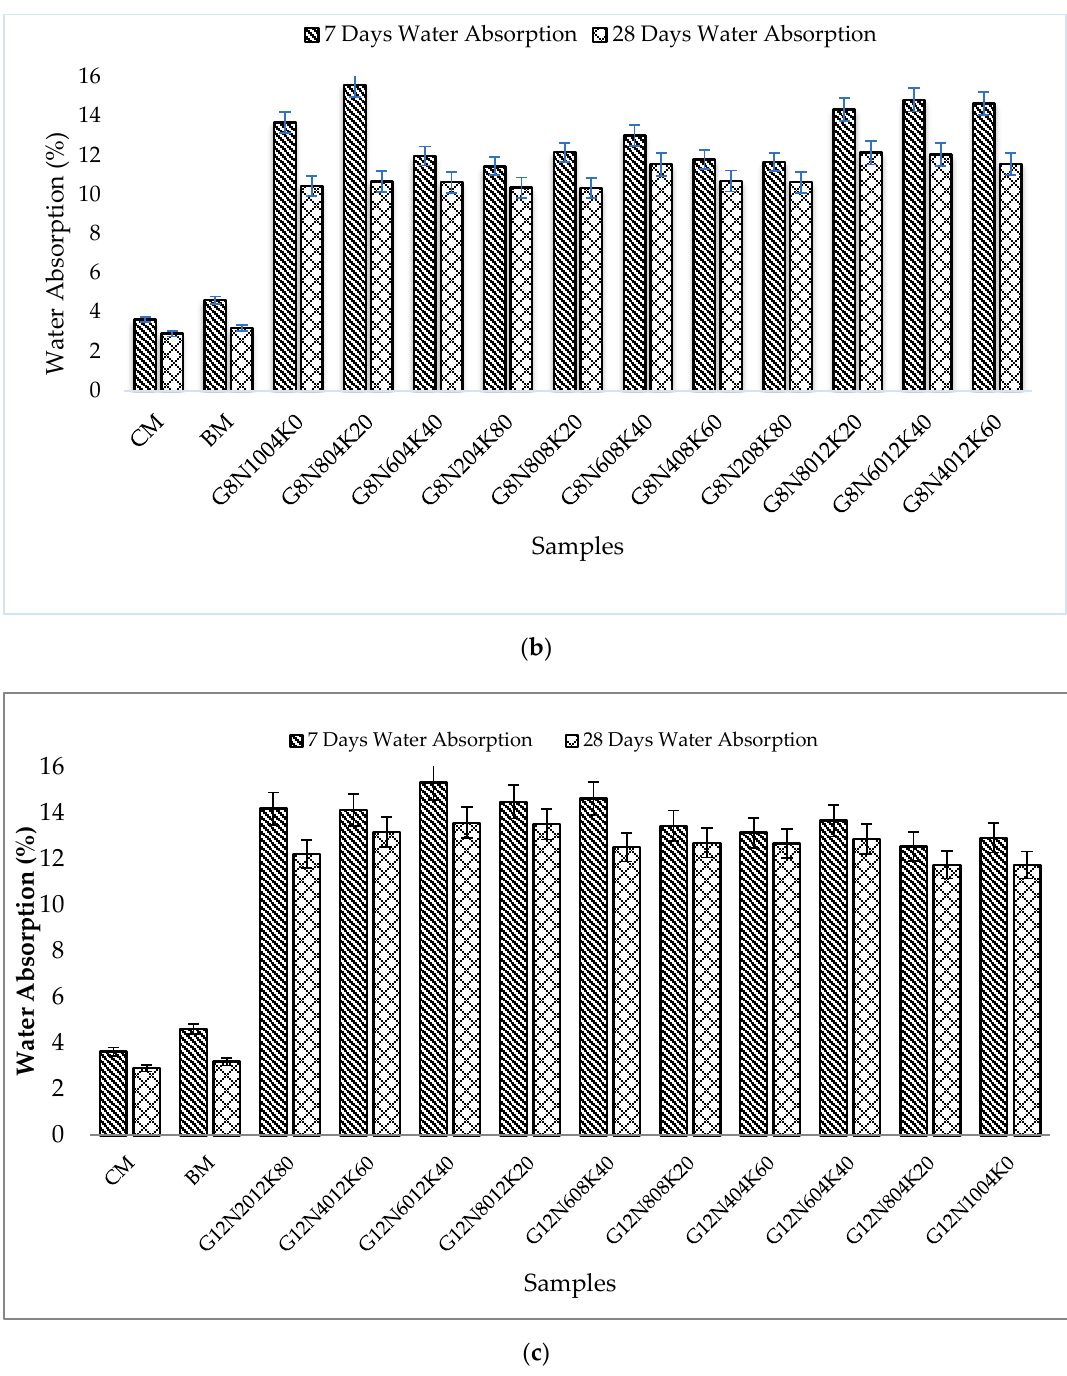
Figure 4. Water absorption of geopolymer cement paste at 7 and 28 days: ( a ) 4 M samples, ( b ) 8 M samples, and ( c ) 12 M samples.